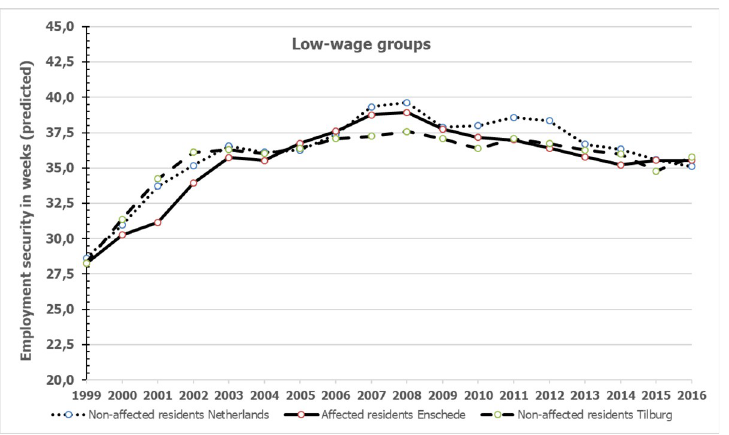
Fig 4. Annual employment security of affected residents with low wages and non-affected control